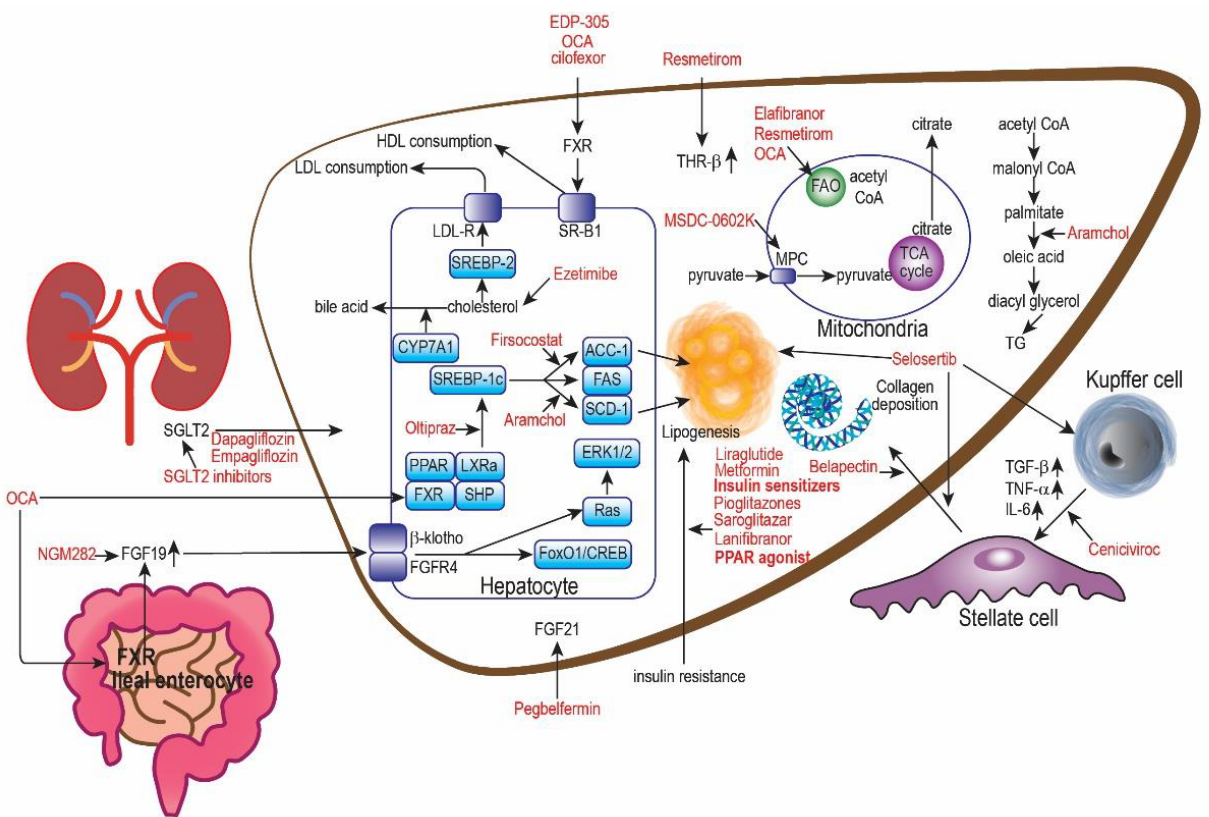
Figure 3. Mechanism of action for various NAFLD pharmacological treatments. Adapted from [90]. Empagliflozin. Empagliflozin works along the same pathway as dapagliflozin. Often